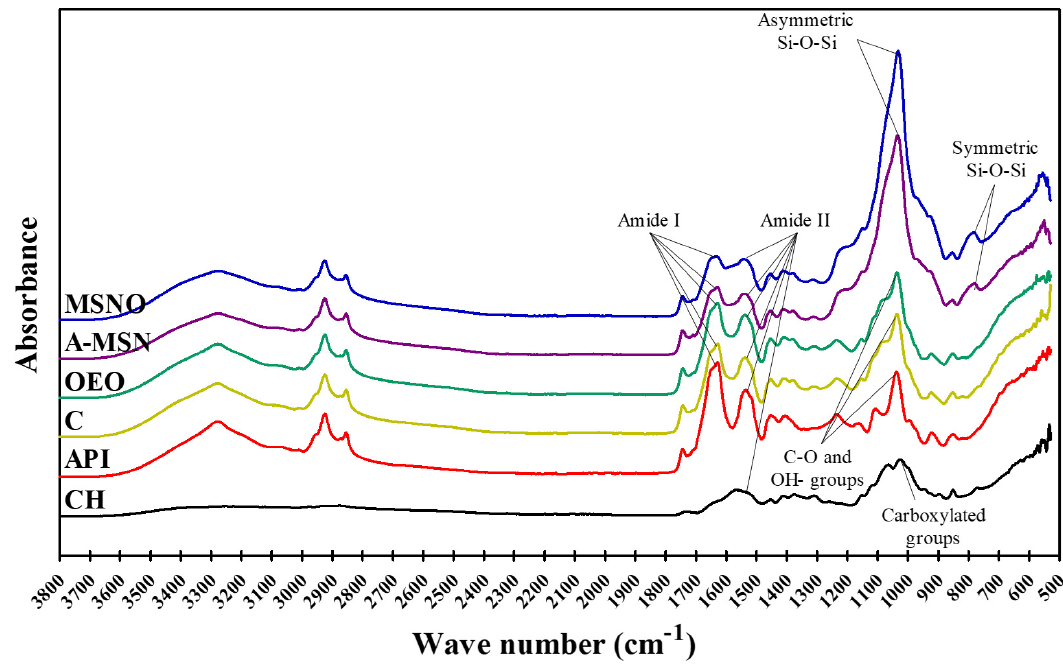
Figure A1. FT-IR spectra of active edible films of chitosan; amaranth protein isolate; amaranth protein isolate:chitosan (4:1 ratio, w / w ): without any addition (C), added with emulsified oregano essential oil (OEO), added with amino-functionalized mesoporous silica nanoparticles (A-MSN), and added with mesoporous silica nanoparticles loaded with oregano essential oil (MSNO).